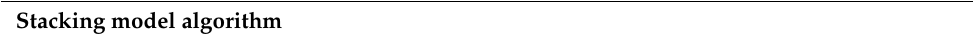
Algorithm 1: The stacking algorithm pseudocode. Stacking model